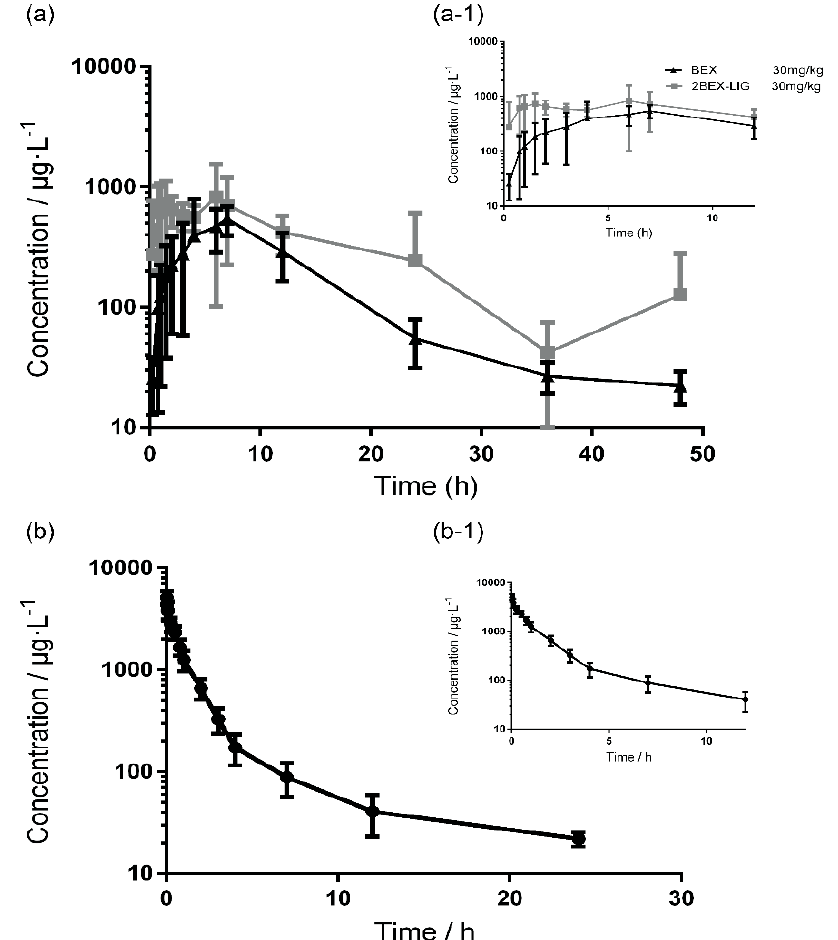
Figure 8. The mean plasma concentration–time curve of bexarotene (BEX) in SD rats: ( a ) orally administrated with BEX (30 mg/kg) and 2bexarotene-ligustrazine (2BEX-LIG) (equivalent to 30 mg/kg BEX); ( a-1 ) the magnification of the concentration-time curve before 12 h; ( b ) the mean plasma concentration–time curve of SD rats after tail vein injection of BEX (5 mg/kg); and ( b-1 ) the magnification of the concentration–time curve before 12 h. n = 6.